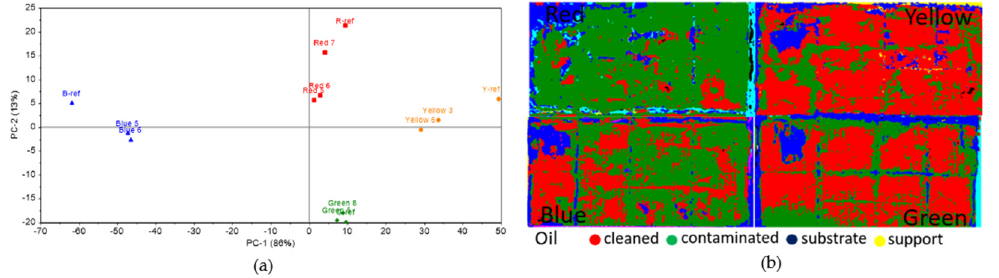
Figure 11 . Colorimetric and hyperspectral evaluation of SO decomposition by fungal lipase ( a ) Score plot of the first 2 PCs, based on colorimetry data; ( b ) SAM images based on hyperspectral